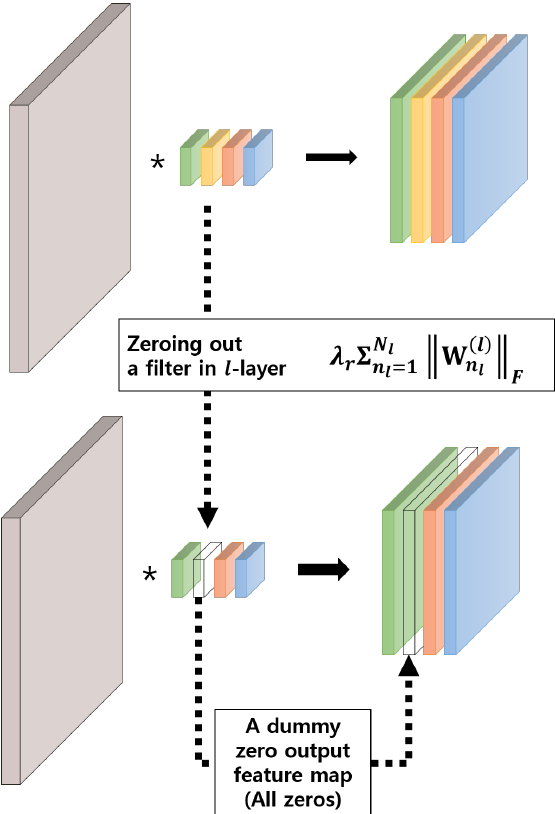
Figure 2. A graphical illustration of a filter-wise group sparsity regularization. Notably, zeroing out a filter in the l -th layer results in a dummy zero output feature map, which in turn makes a corresponding channel in the ( l + 1 ) -th layer